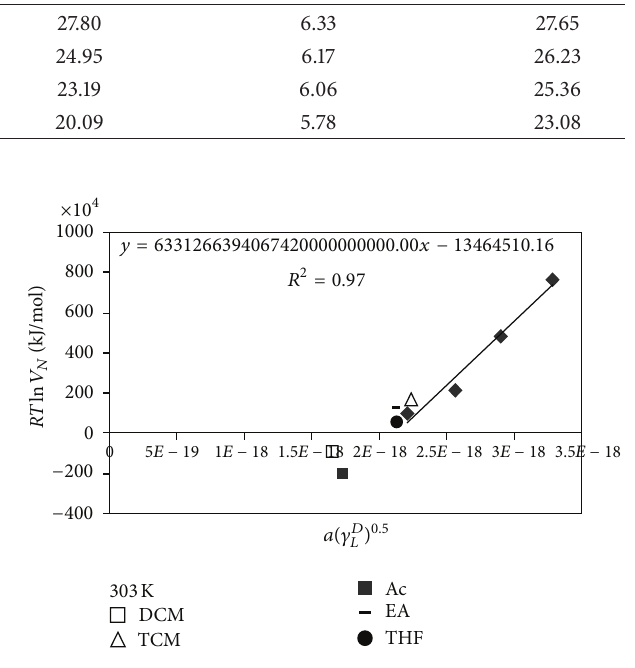
Figure 5: A plot of 𝑅𝑇 ln 𝑉 𝑁 versus 𝑎(𝛾 𝐷 𝐿 ) 0.5 for n -alkanes and polar probes on SBL at 303 K.